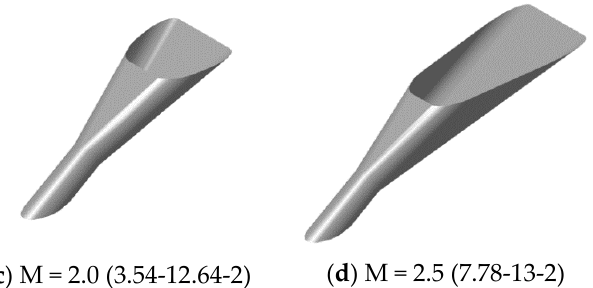
Figure 12. Optimized holes at DR = 2.0 ( u m = 20 m/s ) [14]. Reprint with permission from Elsevier (License number 5087330955198).